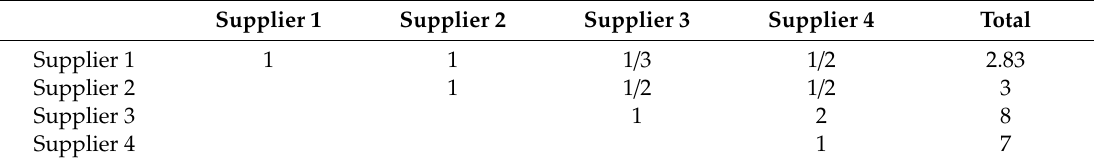
Table 7. The results of pairwise comparison for supplier alternatives with regard to product performance criterion.